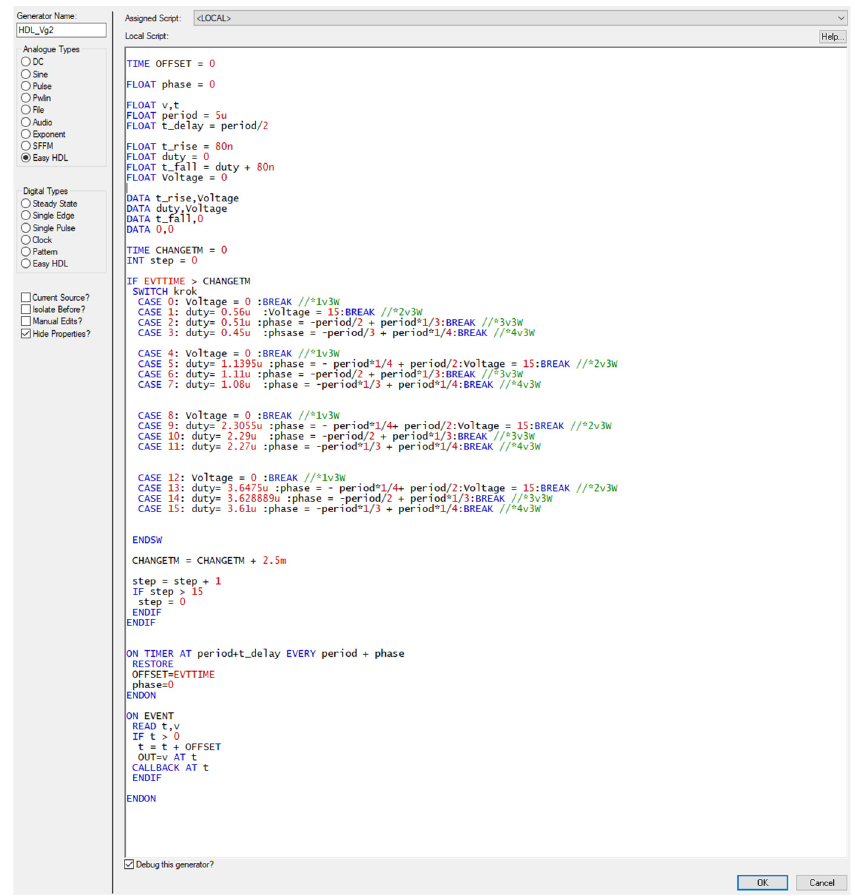
Figure 7. VHDL script for creating dynamic control signals for second leg.